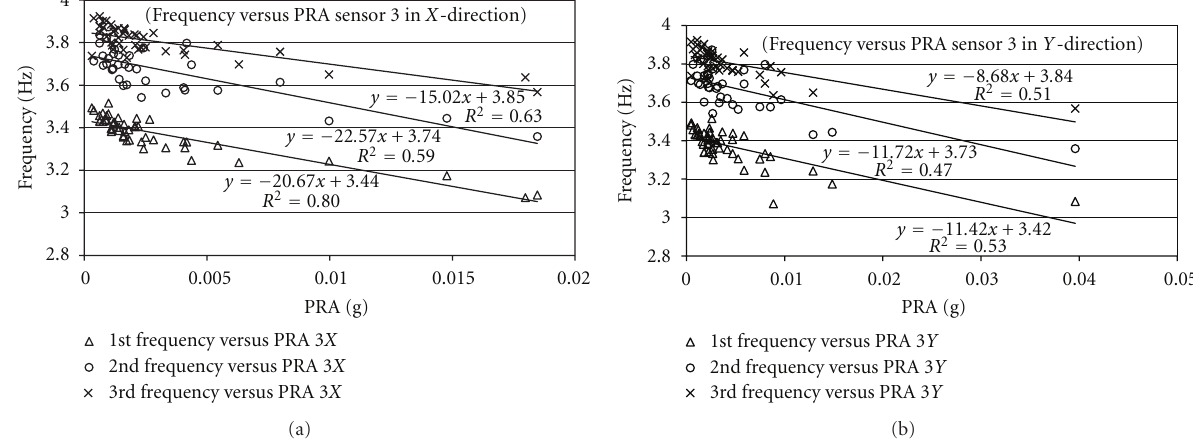
Figure 11: First three modal frequencies of building A for pseudoflexible base case versus PRA of sensor 3: (a) X -direction and (b) Y - direction.